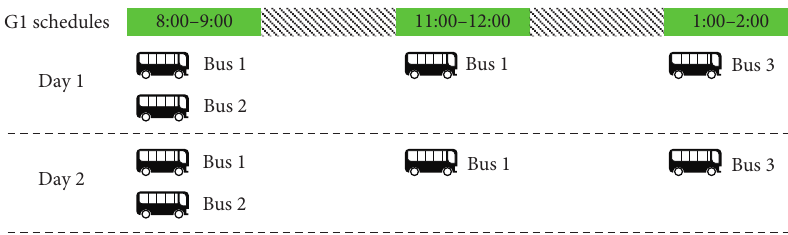
Figure 6: The different bus trips on day 1 and day 2 based on the bus route schedules in Figure 5. Figure 8. In the background, the system periodically saves the current bus location (i.e., current longitude and latitude) for the trip in the database table shown in Figure 11 to allow users (e.g., admin and pas- sengers) to track or replay the trip. The driver must end the trip (to stop the data recording) when the bus arrives at its final destination. Further, a trip must be canceled in case it was started by mistake.